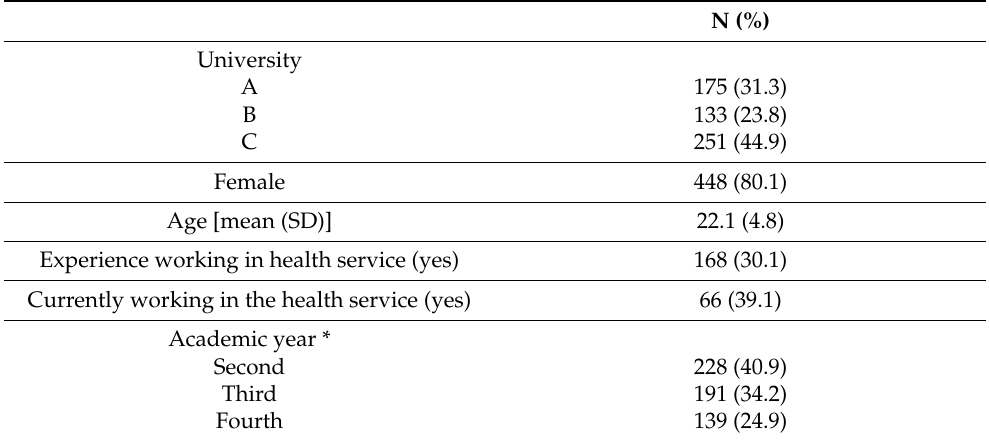
Table 2. Characteristics of